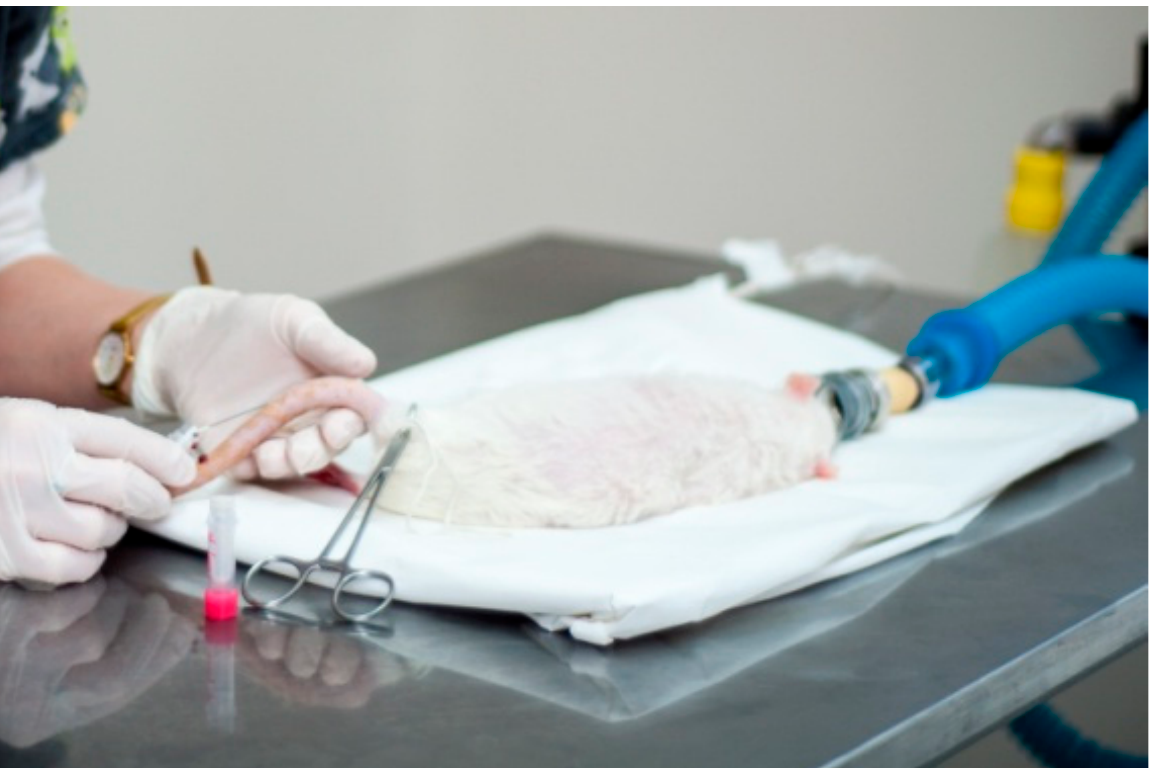
Figure 1. Procedure of blood collection from the lateral tail vein in the rat under isoflurane anesthesia.